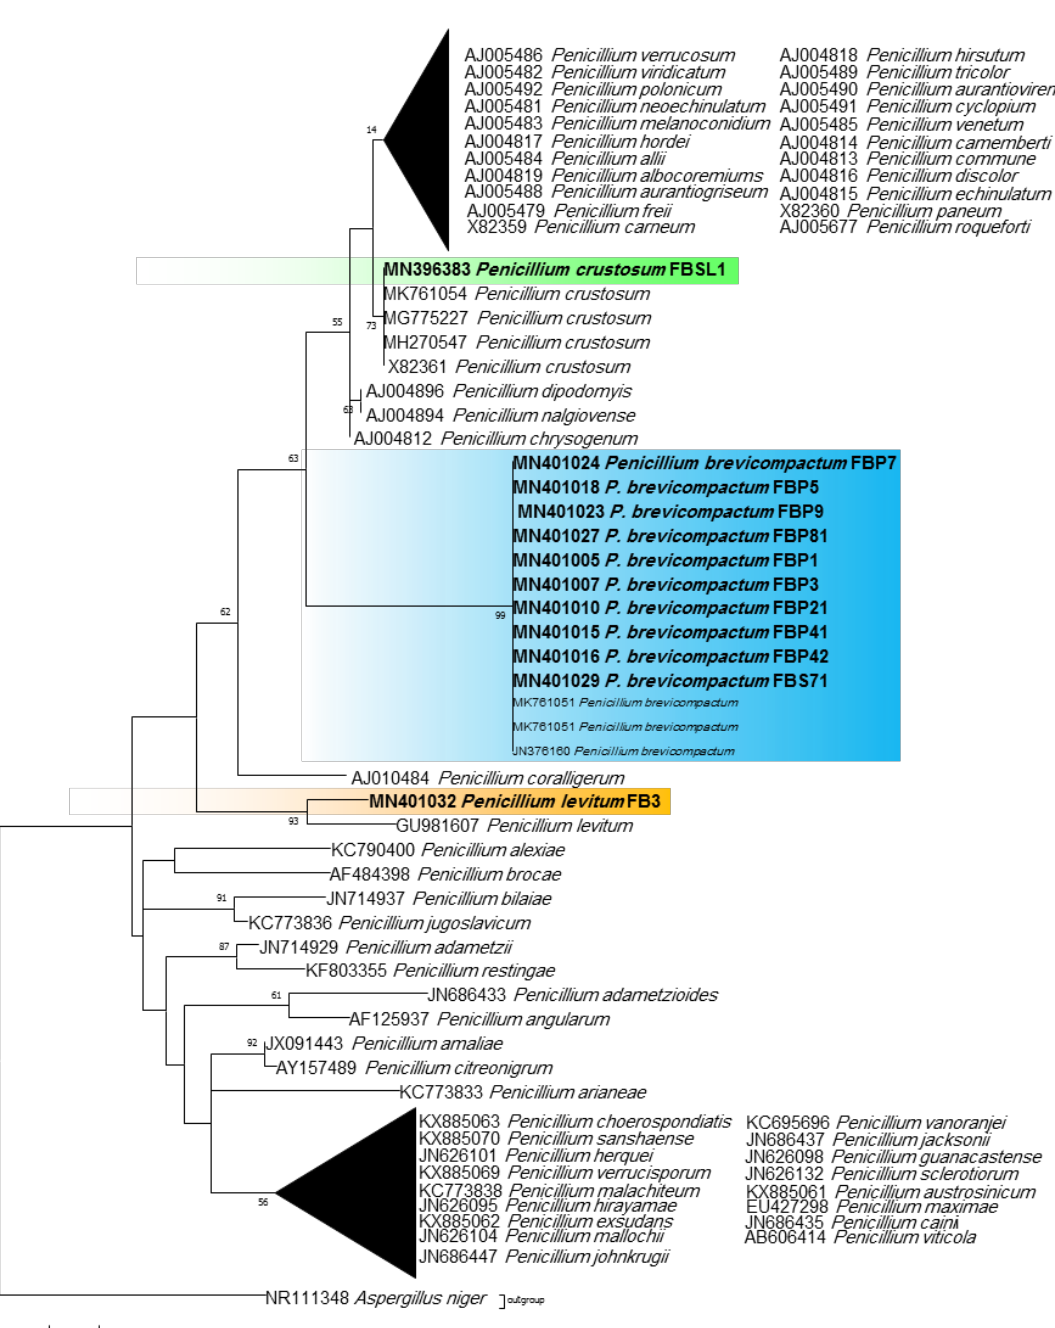
Figure 4. ITS phylogenetic trees of the genus Penicillium and related genera. The analyses were performed based on the alignments of ITS1-5.8S-ITS2 (502 bp) using the maximum likelihood method from isolates in this study (bold) and validly published sequences from GenBank. The numbers next to the branches show bootstraps values ≥ 50%. Aspergillus niger was considered an outgroup.